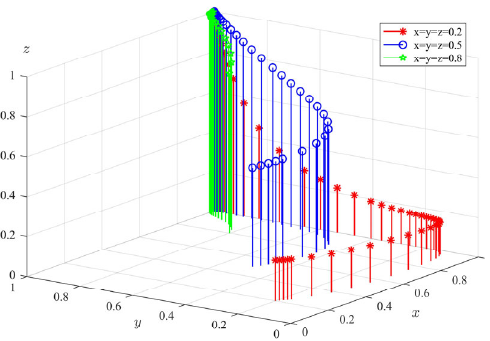
Figure 5. Simulation results of the initial strategy of participating